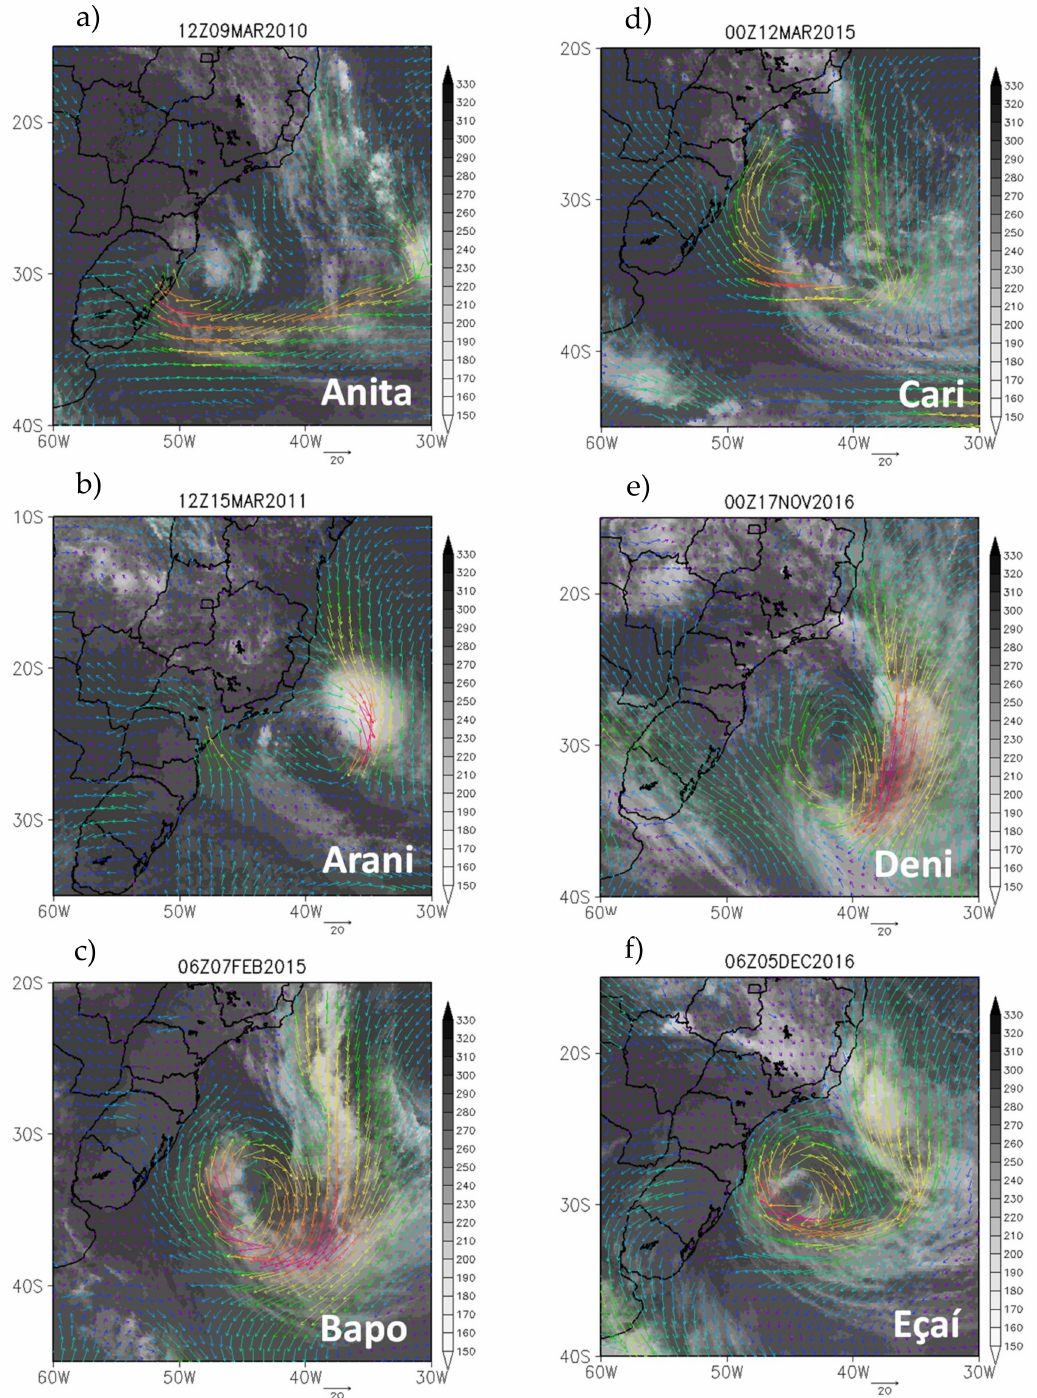
Figure 8. Brightness temperature near 11 microns (K) and intensity and direction of the wind at 925 hPa (m · s − 1 ) for the maturity phase of the six named subtropical cyclones over the South Atlantic Ocean (SAO): ( a ) Anita, ( b ) Arani, ( c ) Bapo, ( d ) Cari, ( e ) Deni and ( f ) Eça í . Convection is an important process for transporting heat and moisture from near-surface layers to upper levels of the troposphere. According to References [33,34], moist convection is the primary driving force for tropical cyclone development. As the subtropical cyclones have some features